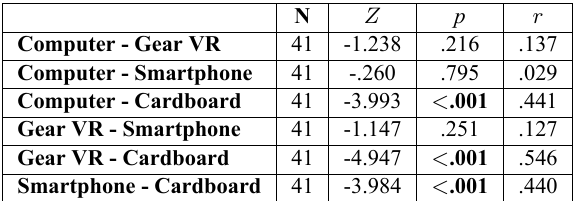
Figure 4. Box plot of total scores in different devices. Table 6. Wilcoxon signed­rank test for the total scores for all pairs of devices in a within­subject perspective ( α = . 05